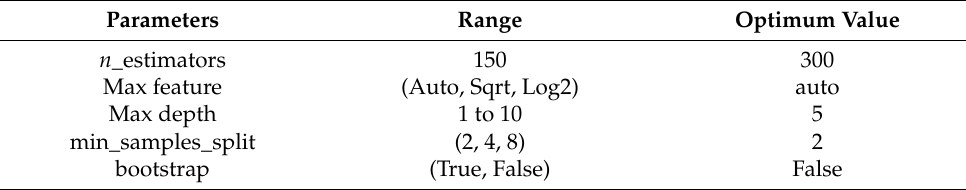
Table 6. ETD regression modeling hyperparameters from the grid